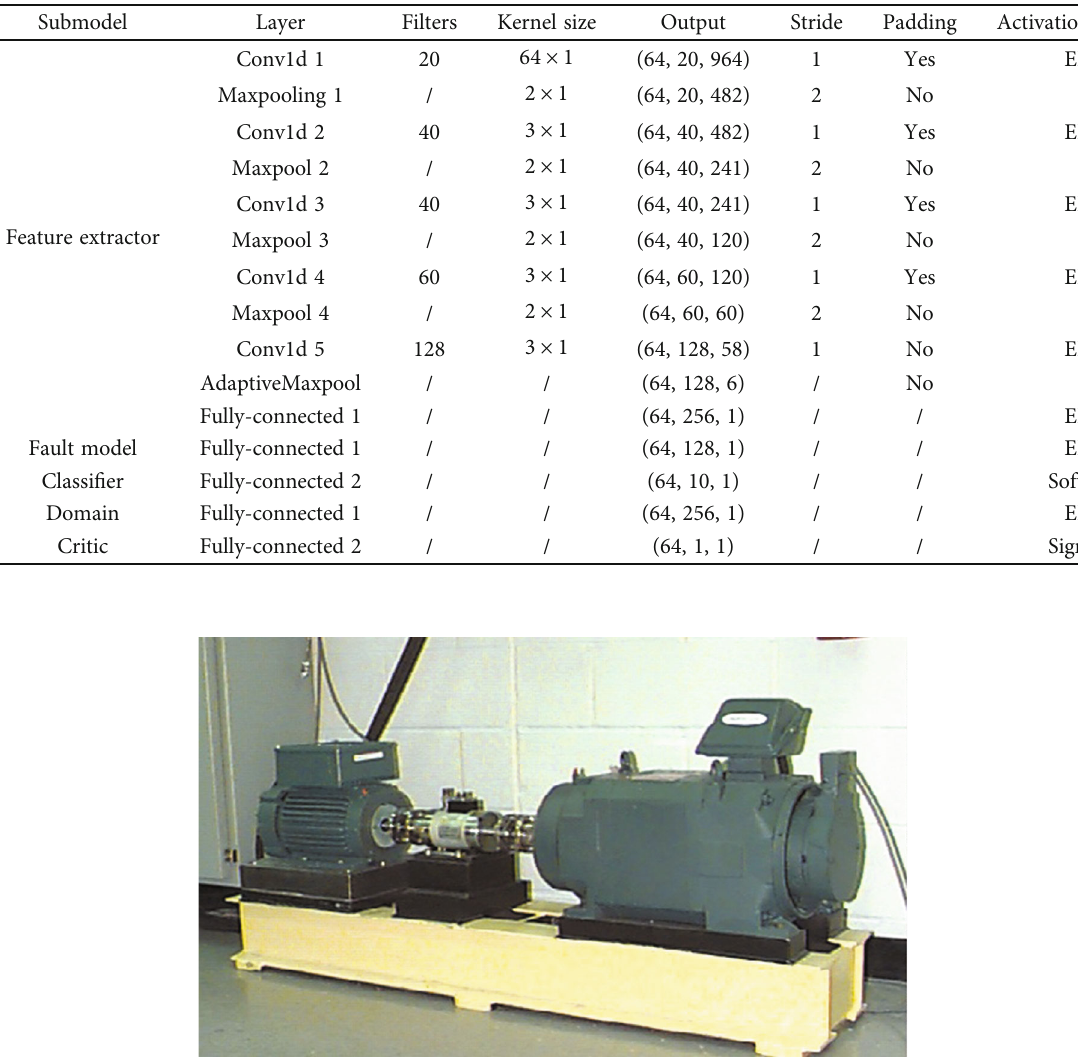
Table 1: Details of proposed CNN deep model in